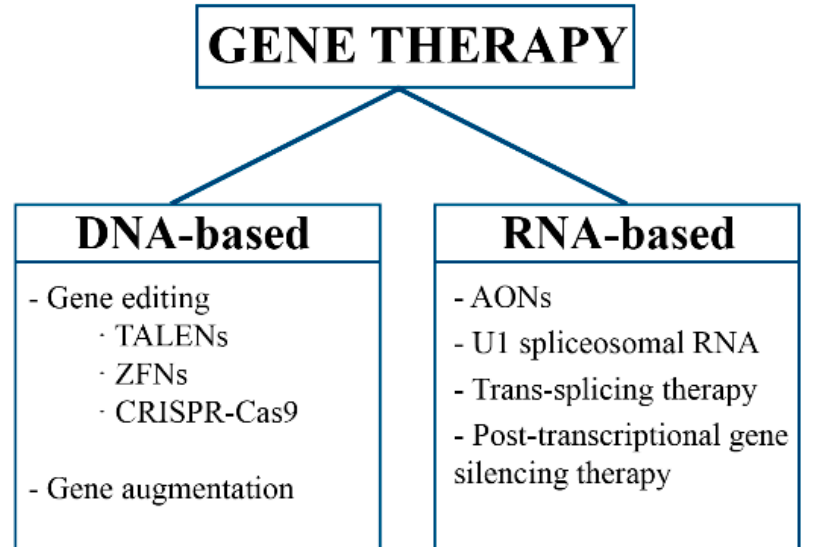
Figure 1. Classification of gene therapy approaches based on nucleic acid type.